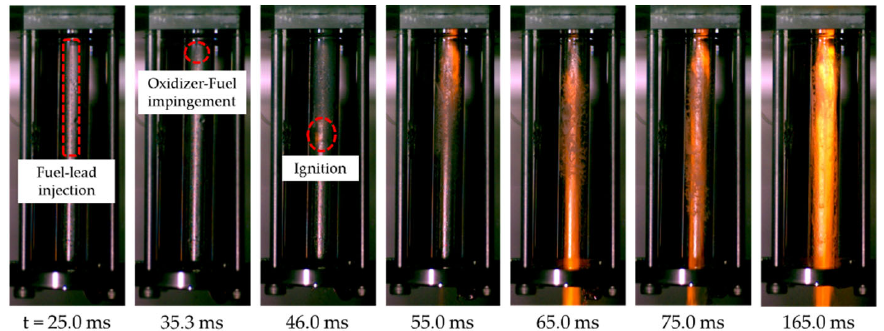
Figure 12. High ‐ speed camera images of hypergolic ignition inside the chamber.